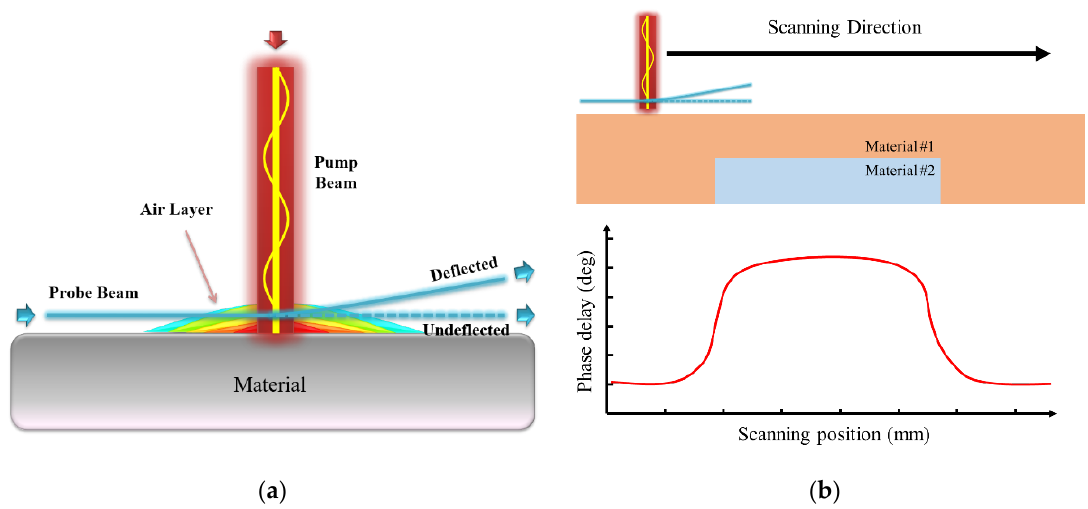
Figure 1. Schematic diagram of photothermal imaging: ( a ) detection of photothermal signals; ( b ) detection of internal material through scanning.